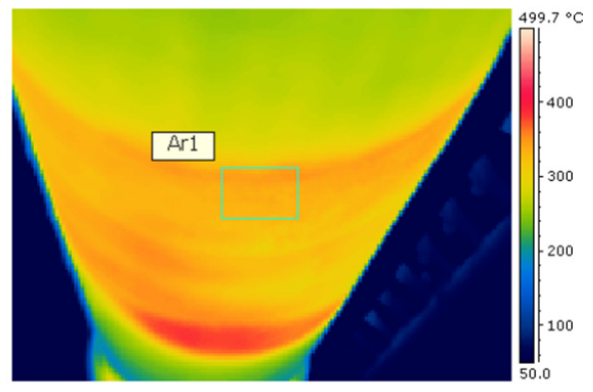
Fig. 3. Temperature distribution on the no. 4 kiln’s mantel.